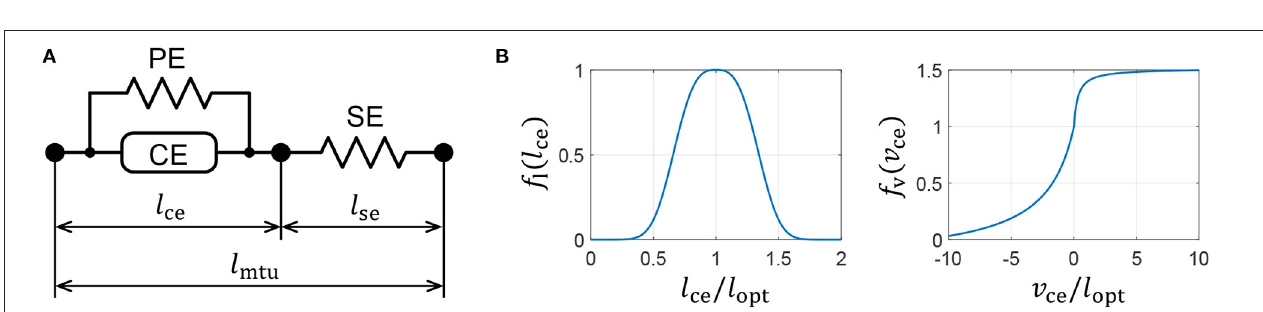
FIGURE 2 | Leg design of the quadruped robot. (A) Degree of freedom for the legs. (B) Detailed mechanism of the legs.